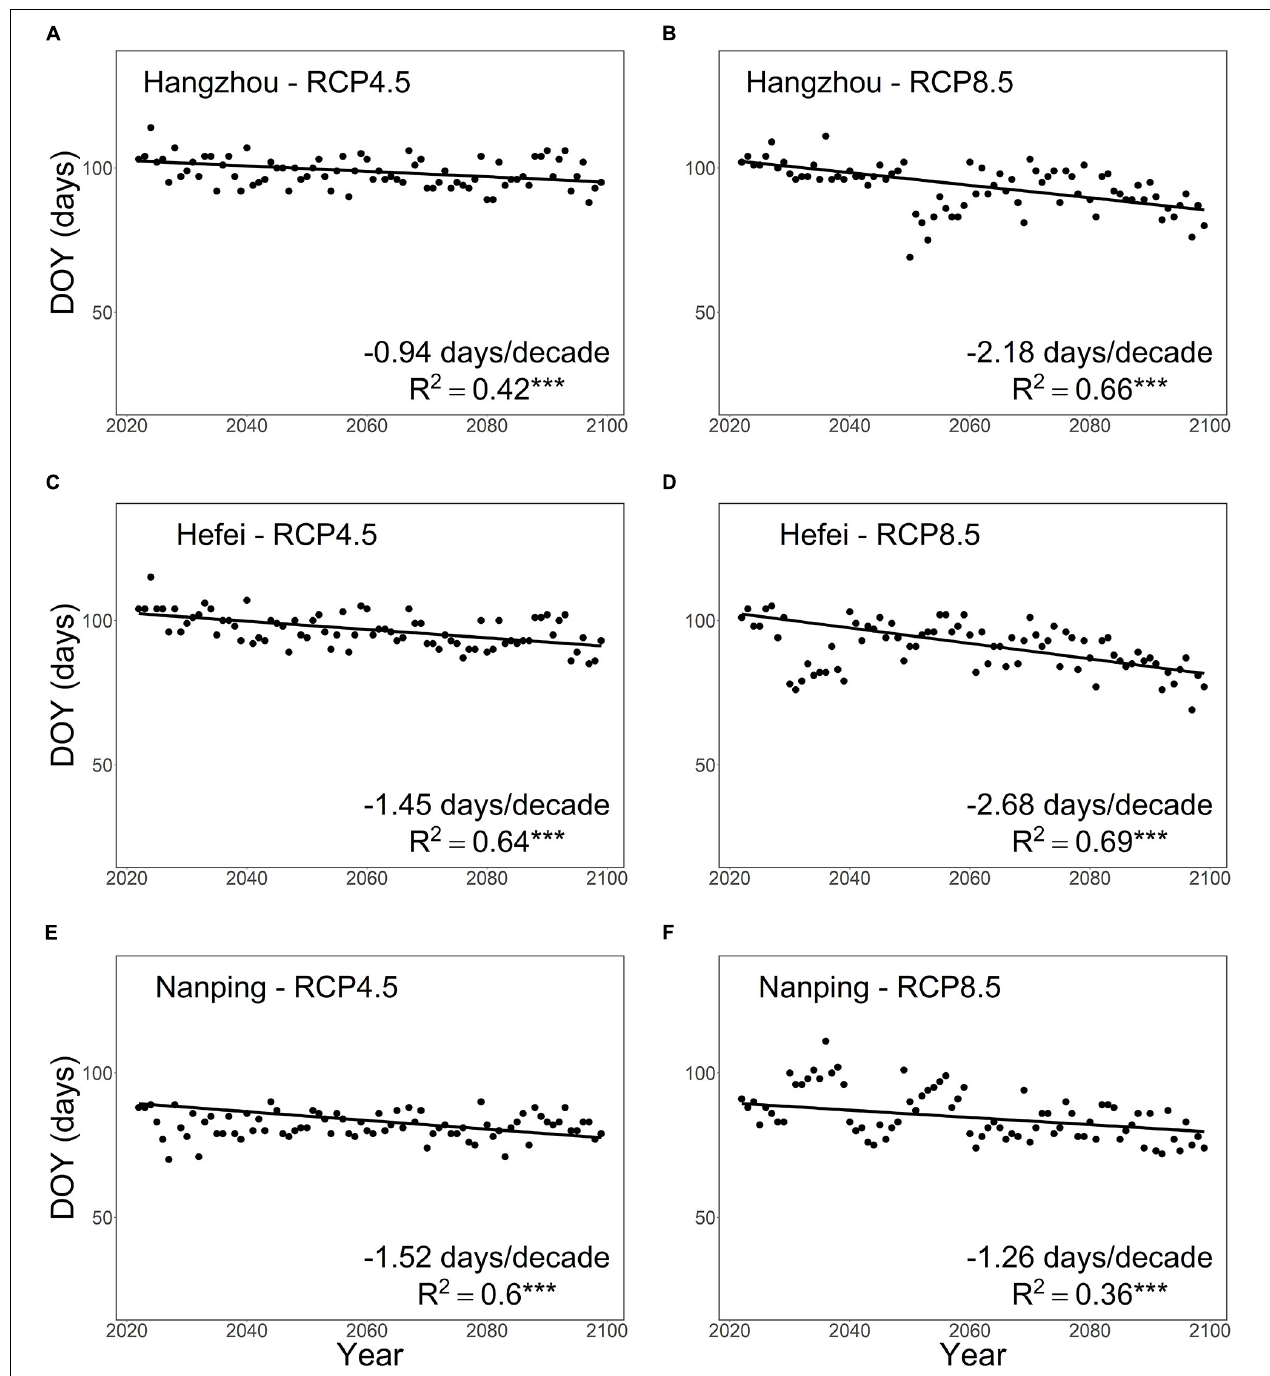
FIGURE 6 | Projected timing of leaf-out in first-year pecan seedlings in three locations in subtropical southeastern China from 2021 to 2099. Using the process-based phenology model developed in this study, the leaf-out was projected for the warming scenarios RCP4.5 (panels on the left) and RCP8.5 (panels on the right) for (A,B) Hangzhou and (C,D) Hefei, located in the main pecan cultivation area in the northern part of the subtropical monsoon climate zone, and for (E,F) Nanping, located south of the main pecan cultivation area. “***” indicates significance at P <